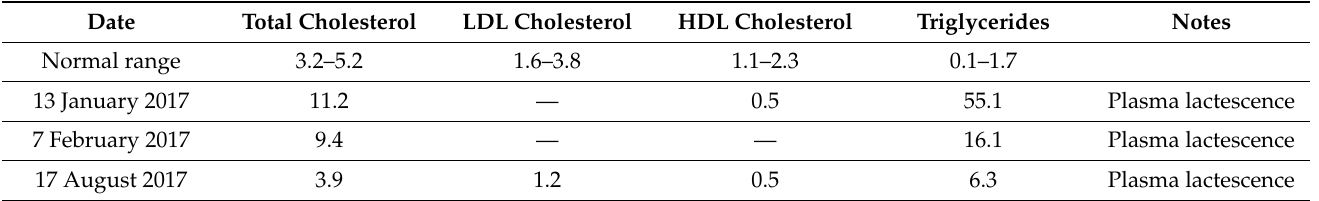
Table 2. Dynamics of the patient’s lipid levels during diet and medication uptake.